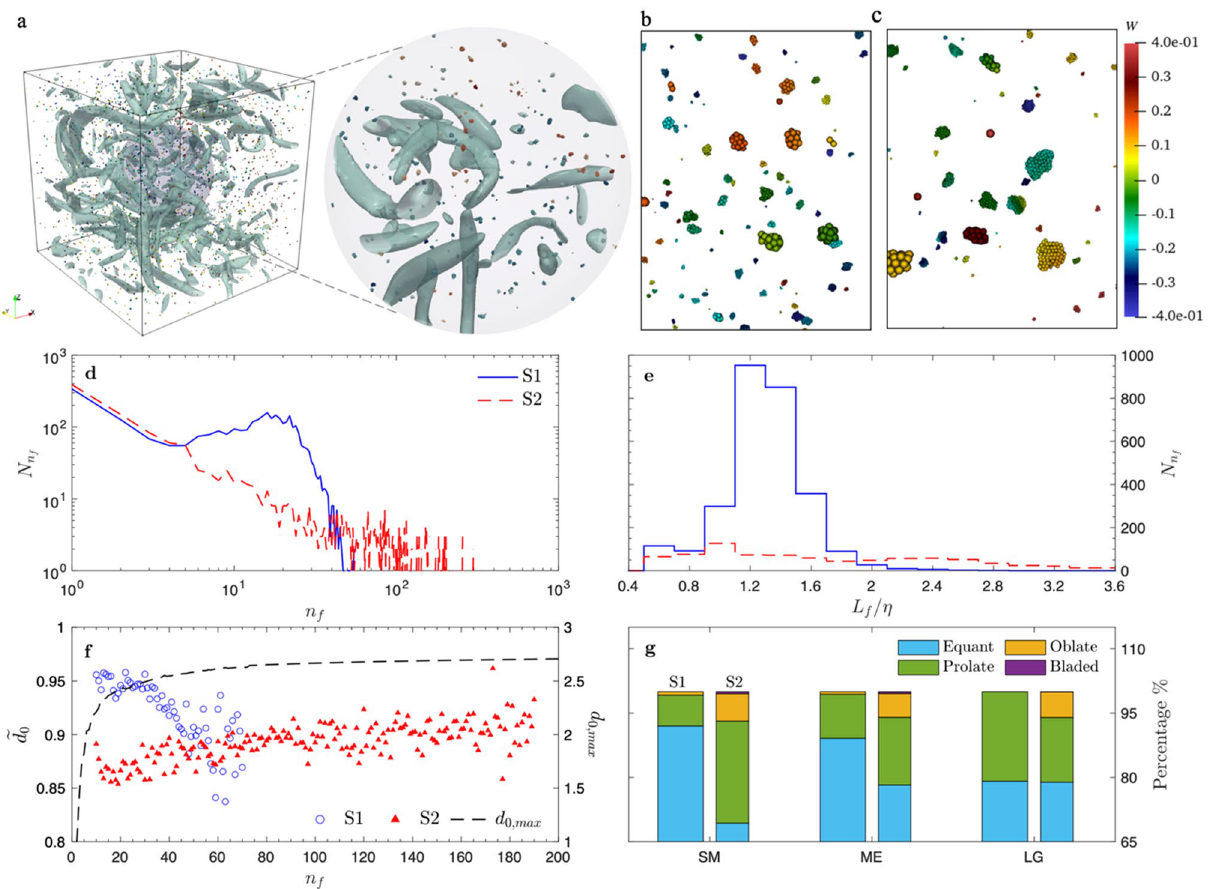
Figure 1. Flocs in homogenous isotropic turbulence. ( a ) Instantaneous flow field with flocs of case S1 at later stage, with a zoomed in view within a sphere of radius 2 at the domain center. The green iso-surfaces are turbulent coherent structures visualized by the (cid:31) 2 method 48 , showing the region of vortices. Particles are colored with their vertical velocity. ( b, c ) The zoom-in view shows flocs at a later stage for case S1 and S2. Small and compact flocs are generated, while larger flocs are more elongated in case S1 ( b ). In S2 ( c ), with greater particle stickiness, much larger flocs consisting of hundreds of particles are generated. Smaller flocs show irregular structures, while larger ones are much more compact. ( d, e ) Floc size distribution N n based on primary f particle number n f and floc size L f at equilibrium. Distribution with peak around Kolmogorov length scale is observed for S1 with lower Co in ( e ). Power-law size distribution is observed for case S2 with higher Co in ( d ). d 0 / d 0, max (see Methods) . d 0 ( f ) Normalized fractal dimension of flocs with different n f for case S1 and S2, = d 0 close to 1 indicates compact floc structure. Floc structure becomes increasingly irregular and fragile as they grow in case S1. Although flocs in case S2 are more irregular in general, larger flocs show relatively compact (cid:31) structure and have similar fractal dimension. ( g ) Zingg’s shape classification 49 (Supplementary Table S2) for 10 25, n 26 35 , n 35 70 ) and case S2 flocs within different n f ranges for case S1 ( n f , SM f , ME = f , LG = = − − − 10 30, n 31 70 , n 71 200 ). Smaller flocs in case S1 are likely to have equant shape ( n f , SM f , ME = f , LG = = − − − while those in S2 have a larger portion of prolate and oblate shapes. Large fractions of larger flocs in S1 tends to have prolate shape while large flocs in case S2 are more